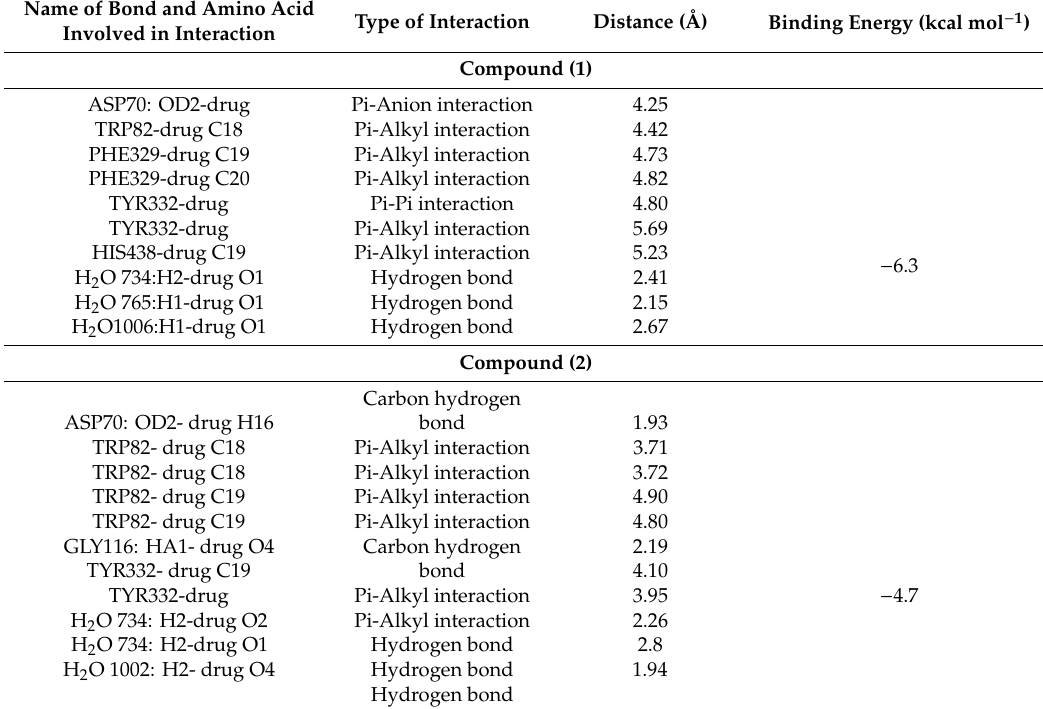
Table 2. Molecular docking parameters of the interaction between isolated diterpenes ( 1 – 3 ) and AChE in comparison to donepezil as a reference drug. Name of Bond and Amino Acid Involved in